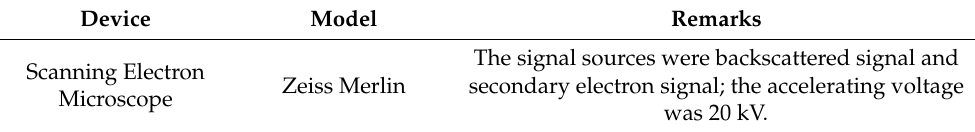
Table 3. Electron microscope information.